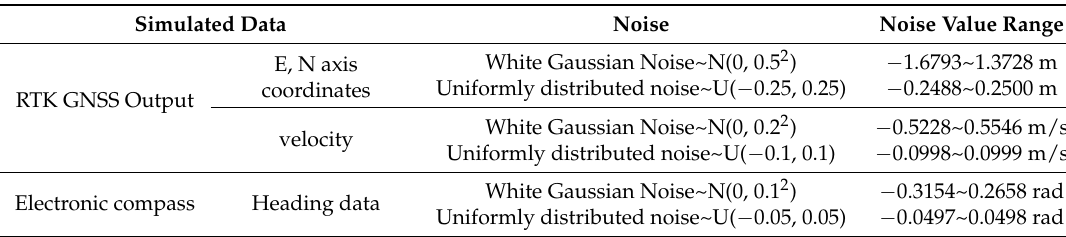
Table 2. Simulated trajectory and related noise added.